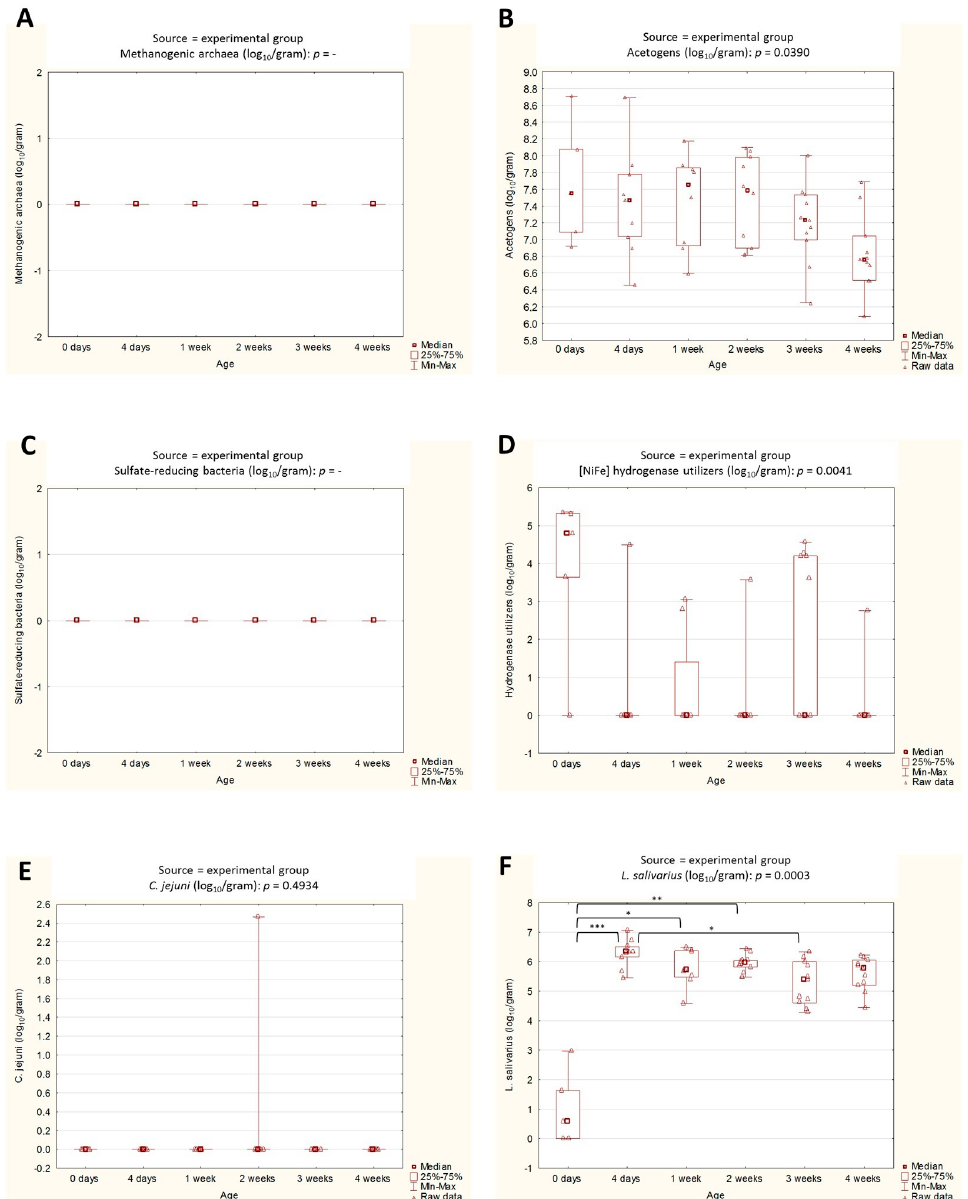
Figure 4. ( A – F ). Box plots representing the abundance of selected microbial groups across age groups in the experimental farm chickens. Statistical significance among age groups is marked by asterisks. Values of * p < 0.05, ** p < 0.01, and *** p < 0.001 were regarded as significant. The non-significant results remained unmarked.